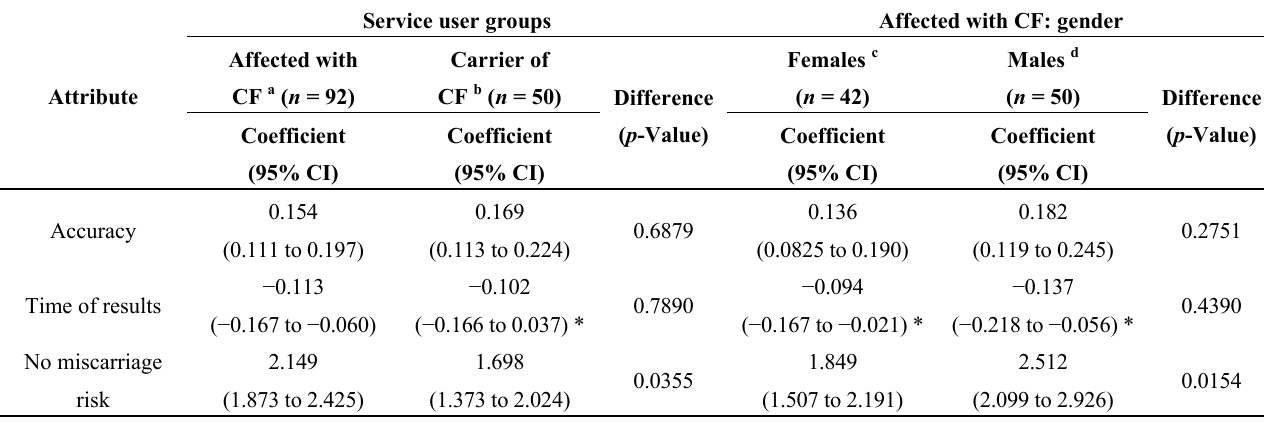
Table 2. Conditional logit analysis regression results to compare service user subgroups. CF, cystic fibrosis.